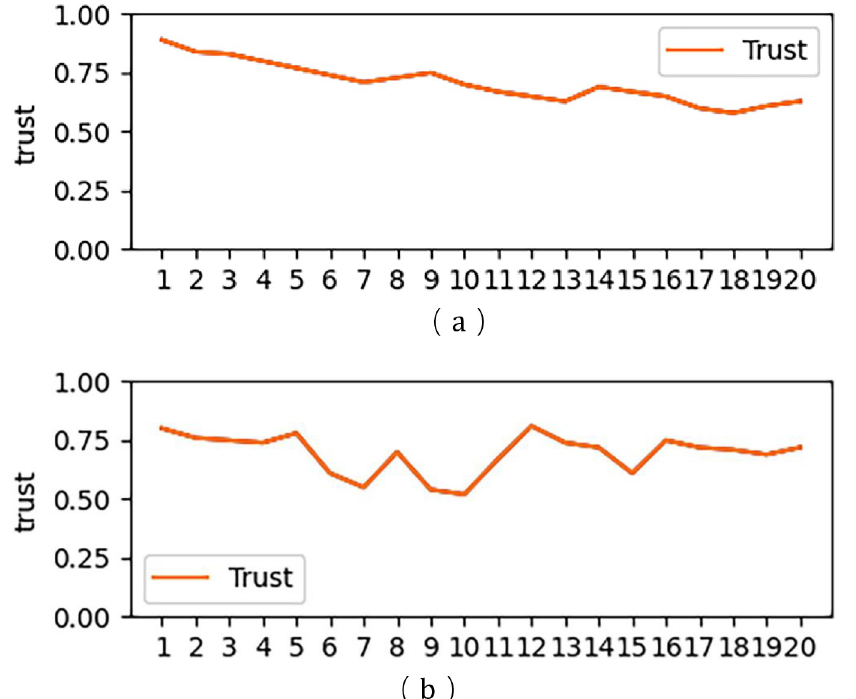
Fig 4. Changes in trust entities. (a: general trust; b: mutation